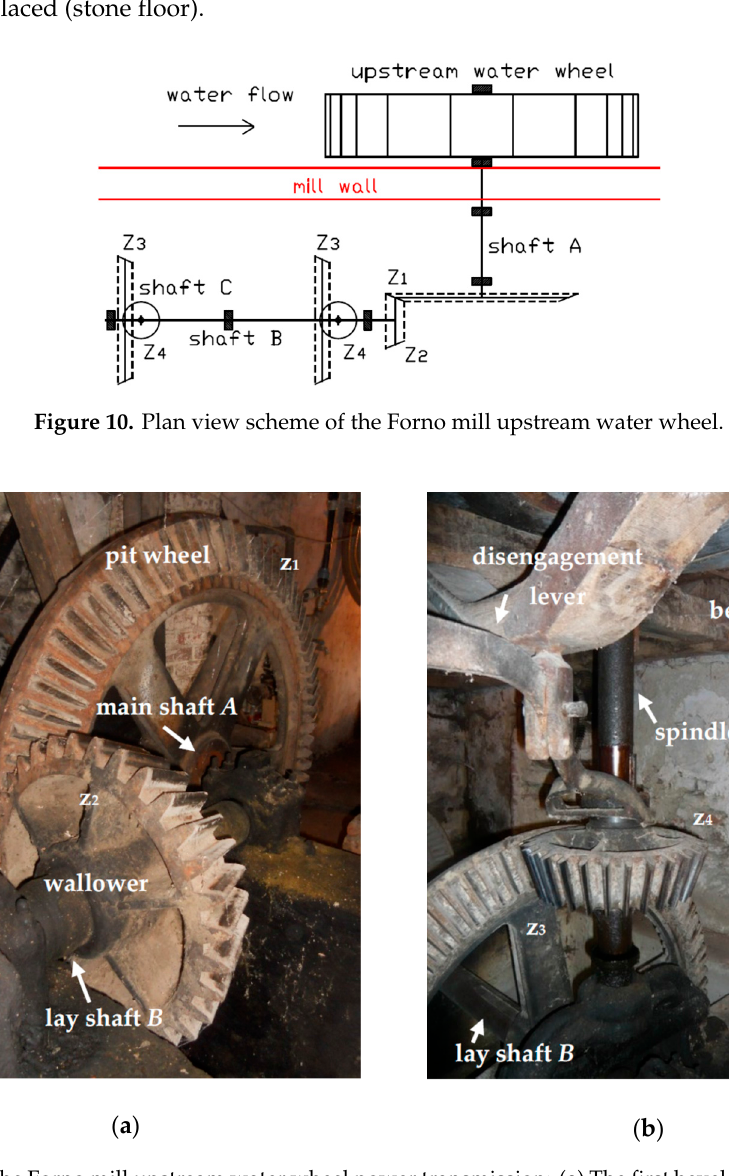
Figure 11. The Forno mill upstream water wheel power transmission: ( a ) The first bevel gear multiplier; ( b ) the second bevel gear multiplier.